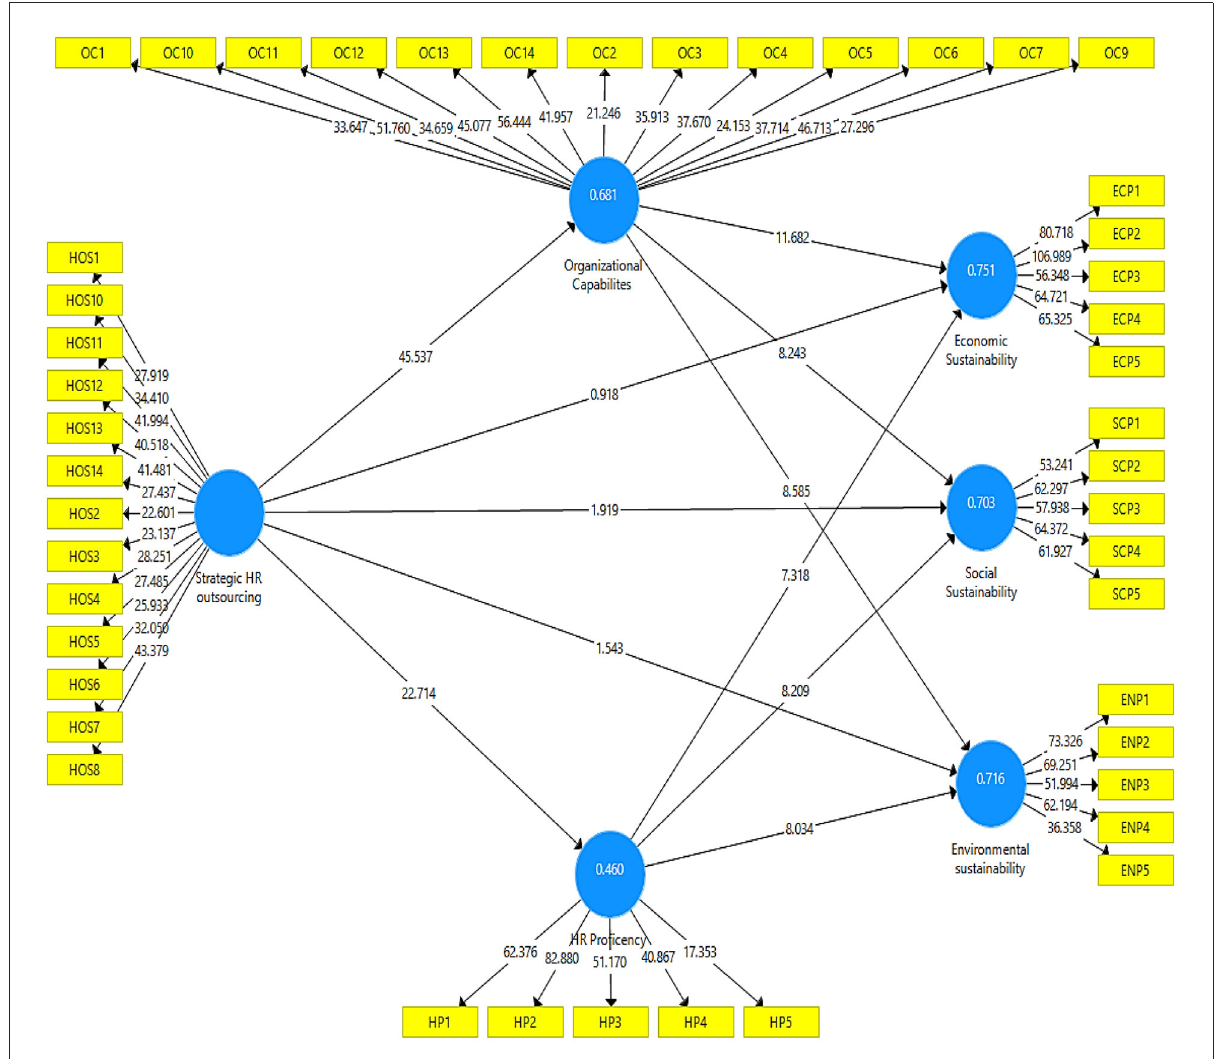
FIGURE2 Output of measurement model